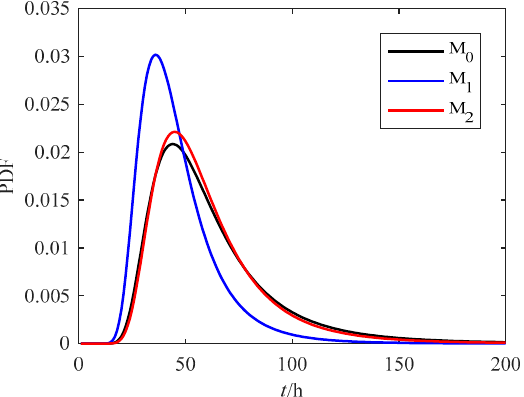
Figure 9. Comparison of PDF of storage lifetime at 70 °C for O-type rubber seal rings.